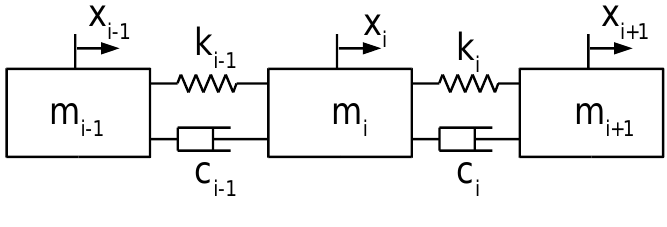
Figure 2. Belt unit